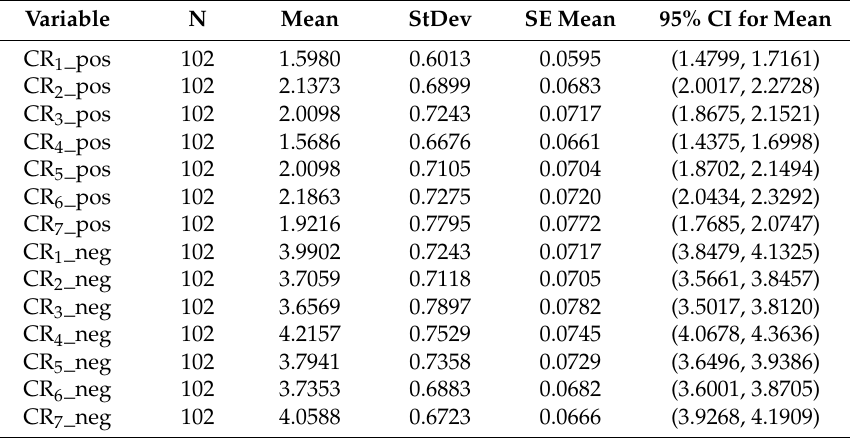
Table 5. Basic characteristics of CRs